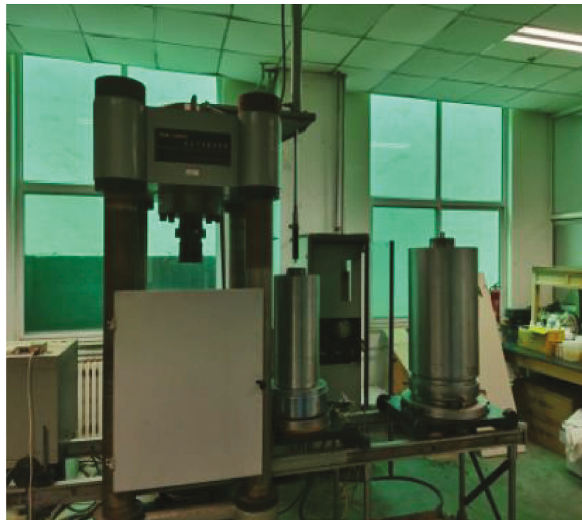
Figure 5: Rock triaxial testing machine.